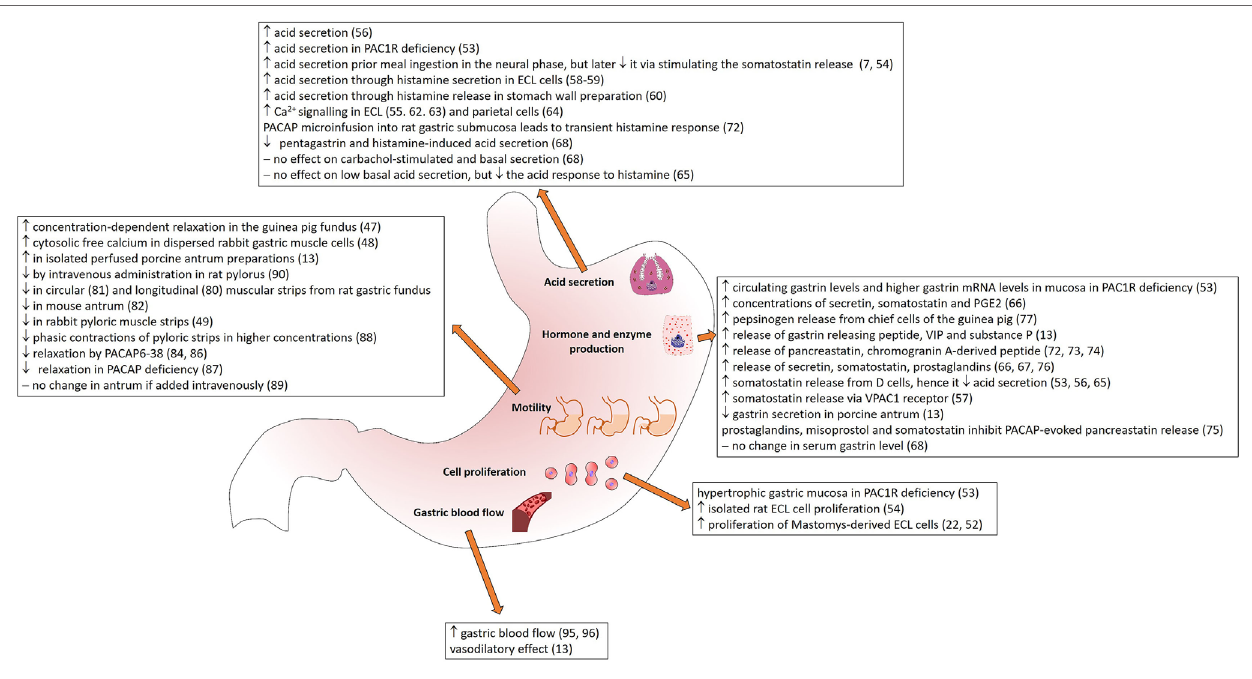
FiGURe 1 | Summary of the effects of PACAP in